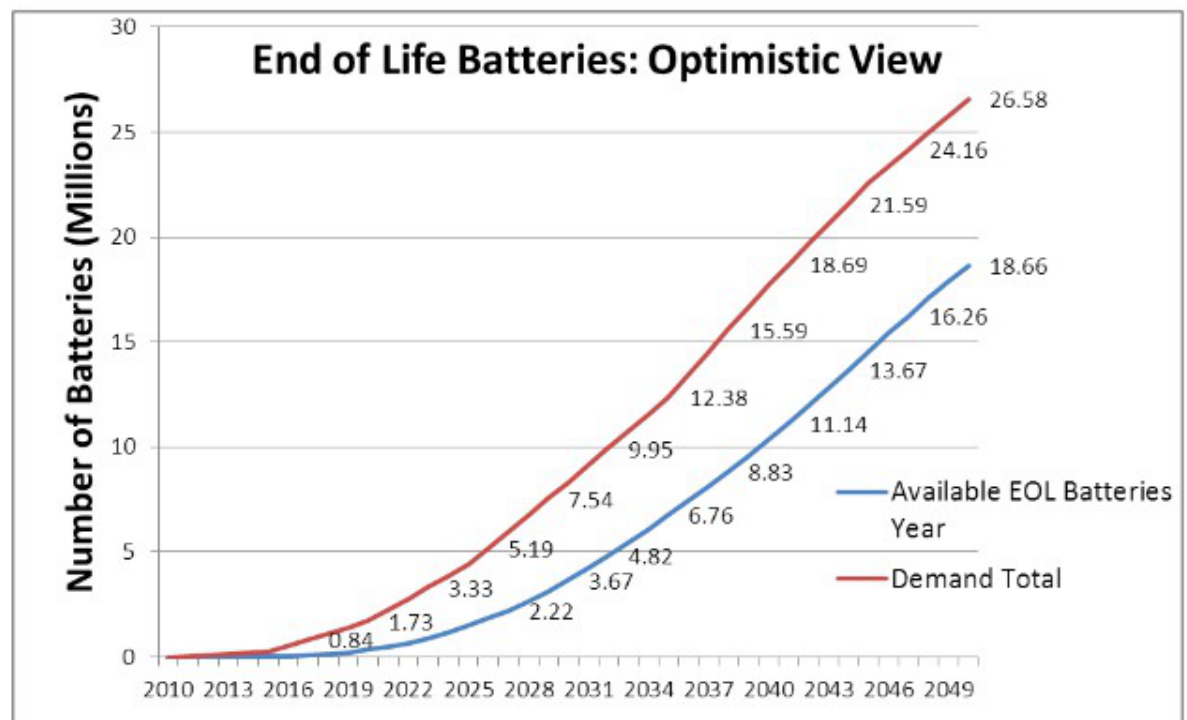
Figure 2. Optimistic View of the Number of Available End of Life Batteries Based on IEA